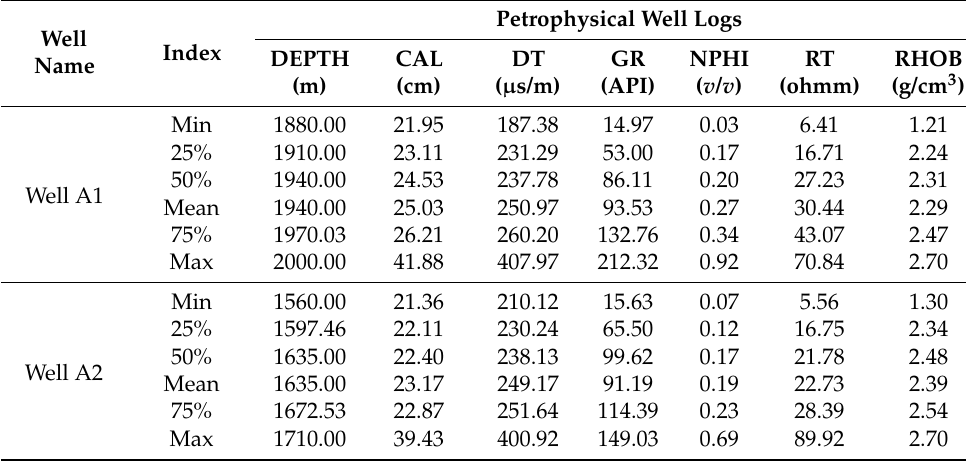
Figure 4. Well logging graph of Well A2 in the studied interval. Table 1. Statistical characteristics of Well A1 and Well A2 in the studied